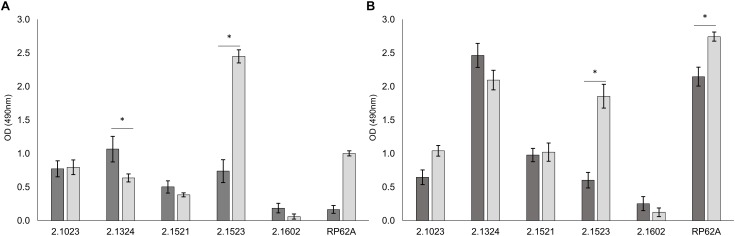
Biofilm formation is dependent on surface hydrophobicity of the support. Biofilm formation on hydrophobic () and hydrophilic () support in TSB (A) and TSB + 1% glucose (B). Significant differences of mean are marked by ∗. Mean ± SE.